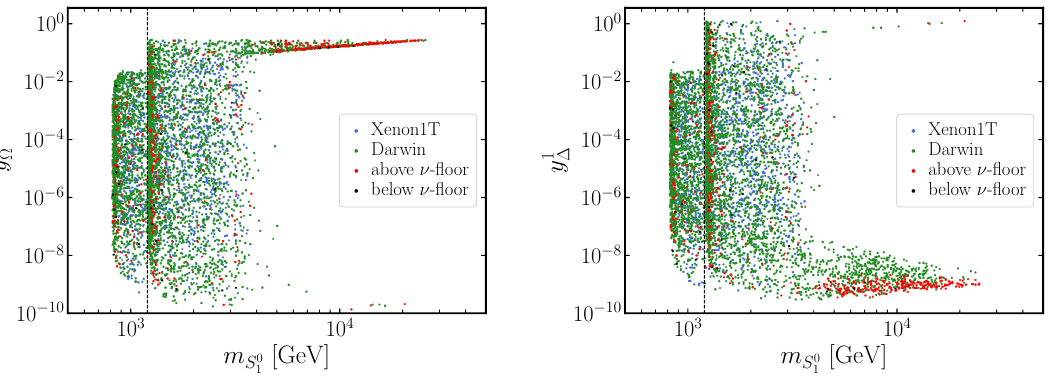
Figure 11 . Scan in the parameter space: Yukawa couplings as a function of the DM mass. The color code is the same as in figure 5, as described in section